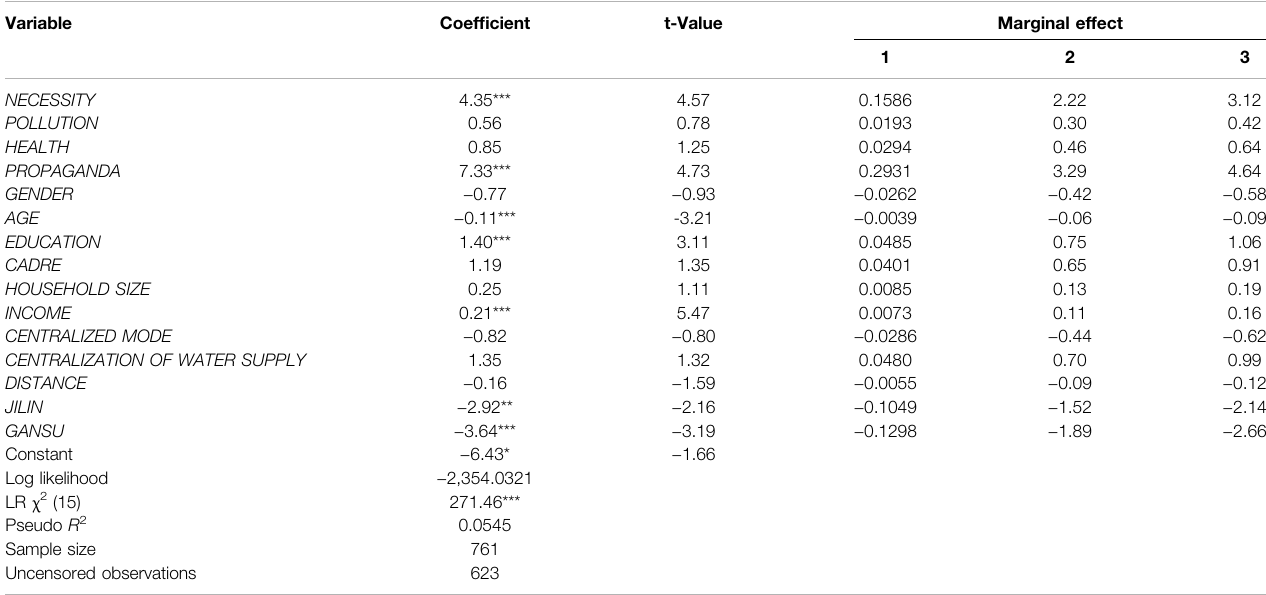
TABLE 6 | Regression results for the farmers ’ WTP for the CMP of